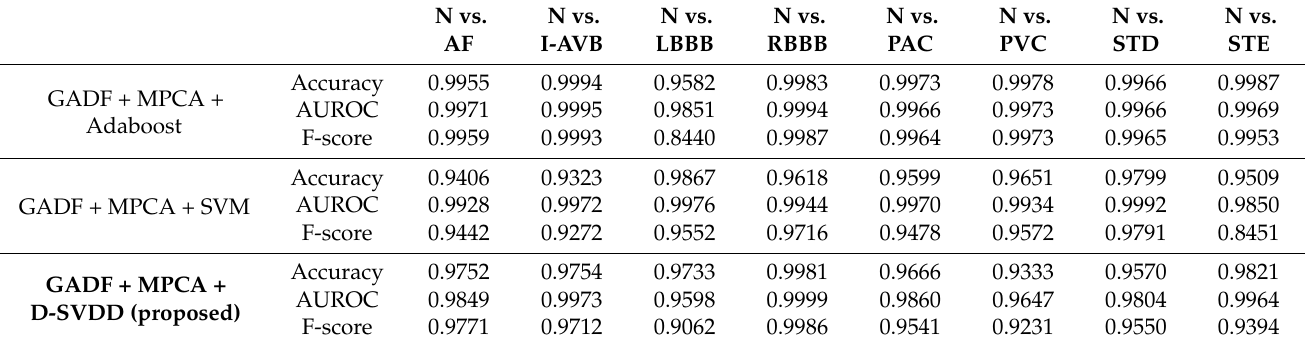
Table 3. Performance Comparison with Supervised Learning Approaches in the Benchmark, Category 3.